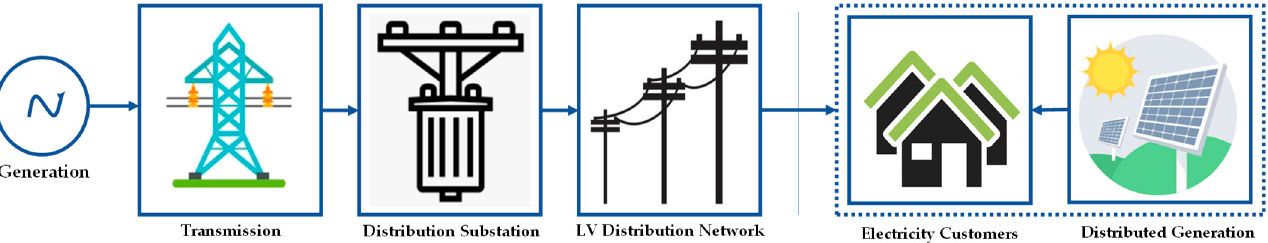
Figure 2. An illustration of distributed generation at consumer (prosumer) premises in future power system.